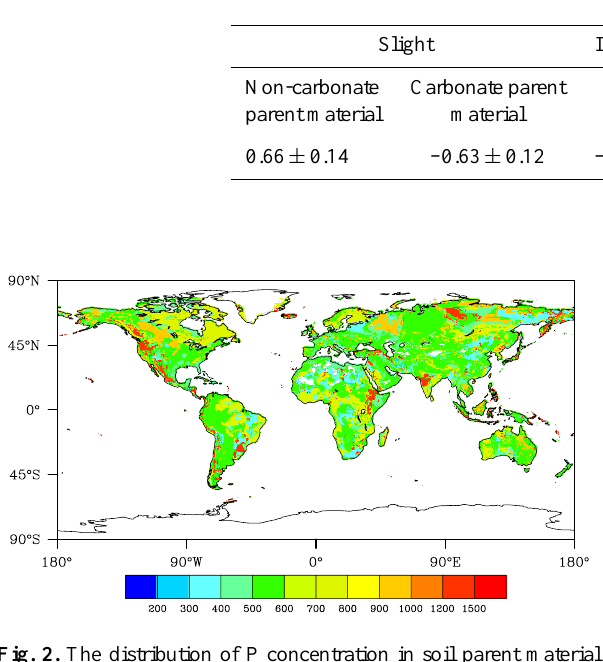
involved are uncorrelated and normally